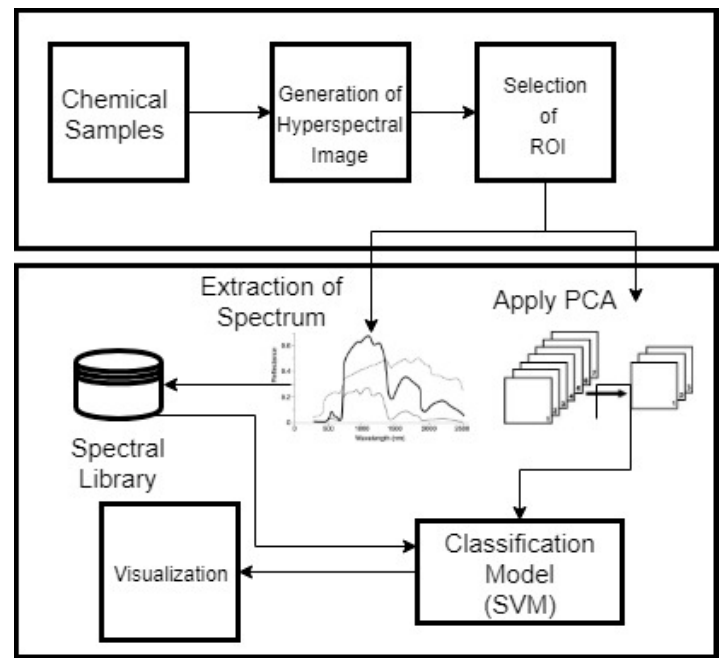
Figure 2. Representation of hyperspectral image as a function of wavelength and image data structure.